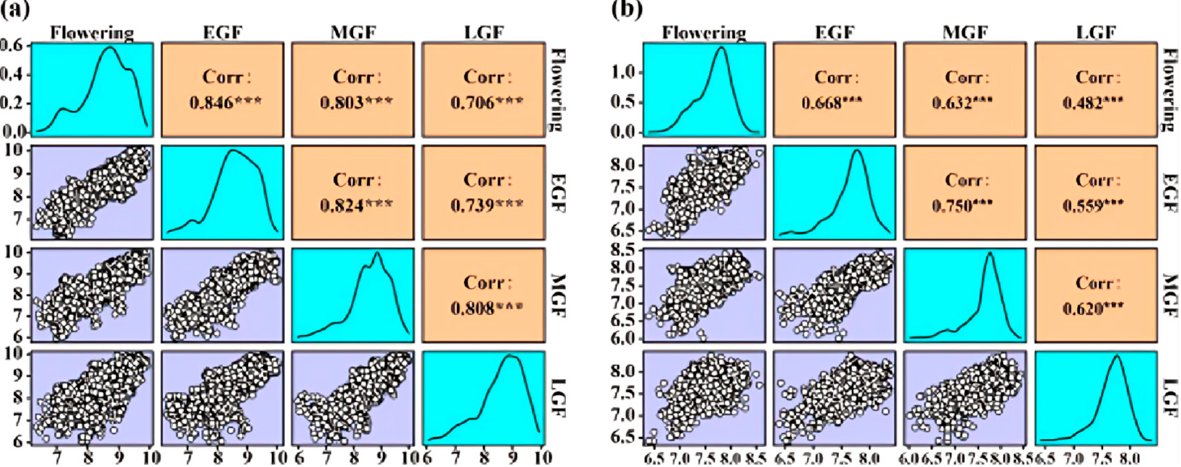
Figure 4. Regression plots, density curve, and correlation coefficient between predicted grain yields of four growth stages under ( a ) full irrigation treatment and ( b ) limited irrigation treatment. *** Correlation is significant at the 0.001 level.